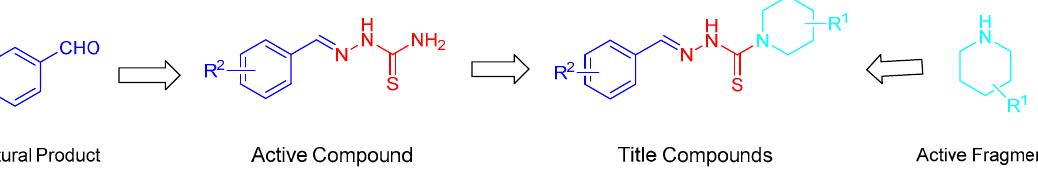
Figure 3. Design strategy of the title compounds thiosemicarbazide derivatives containing piperidine fragments.